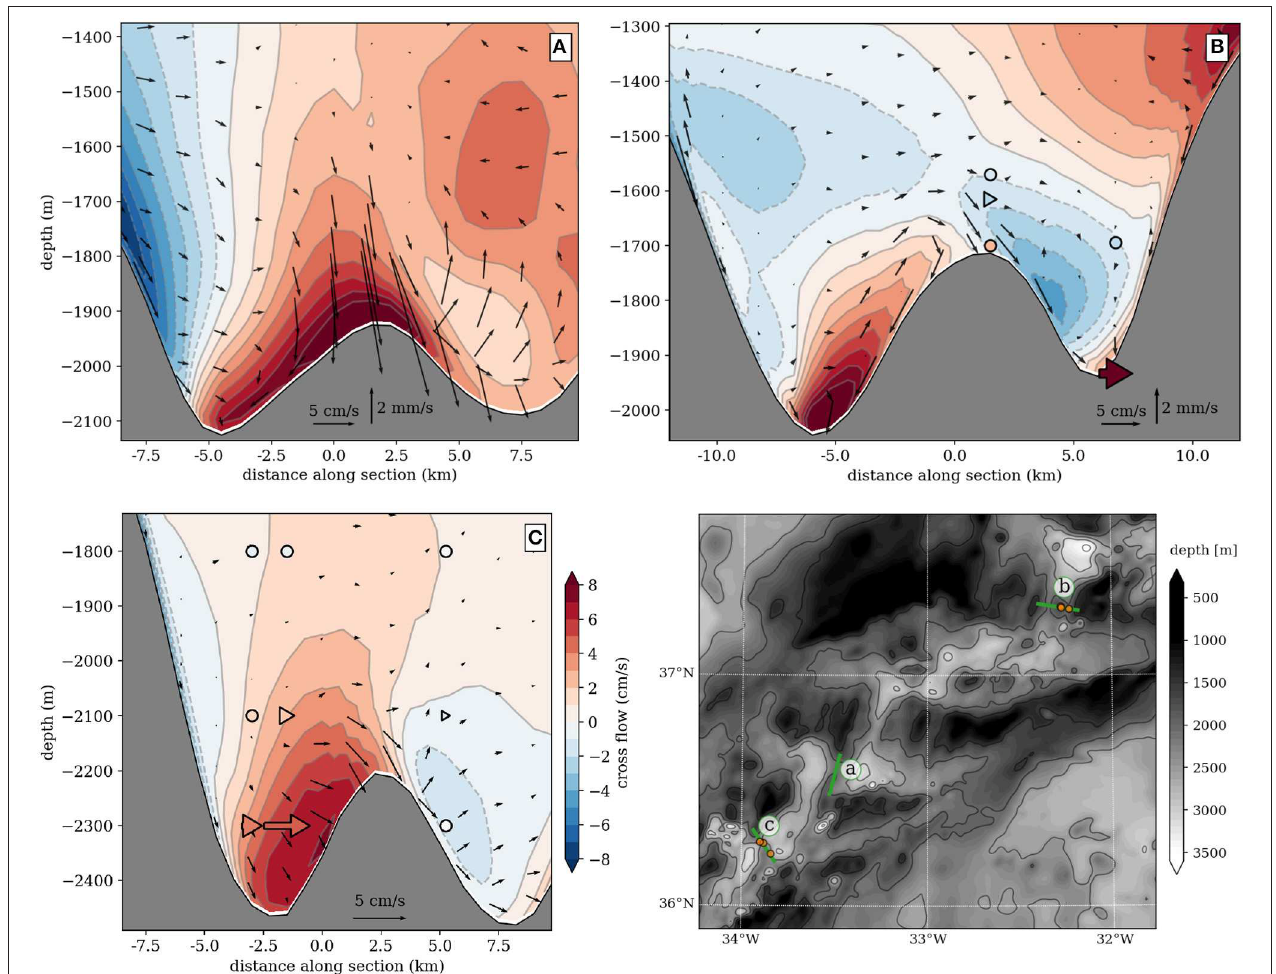
FIGURE 3 | Mean flow at vertical sections across the AMAR-FAMOUS (A) , Lucky-Strike (B) , and Rainbow (C) passages, over the 700 m above the deepest point. Colors indicate the cross-section velocity, for an observer oriented in the same direction as the dominant up-valley flow, and arrows represent the velocity in the section plane. Note that arrows pointing toward (or away from) the topography result from the combination of the cross-section component of the flow and cross-section gradient of the topography (e.g., at Rainbow, the flow is flowing downward along the downstream flank of the sill). Additional velocity data from observations are superimposed in plain arrows for Rainbow and Lucky-Strike, using the same color-scheme for the cross-section component and the same scale for the along-section component (vertical velocity was not measured). A dot is used if the along-section observed velocity is smaller than 0.4 cm/s . The topography is taken from the numerical simulation. The lower right panel shows the location of the sections (green line) over the topography (shallower depth are darker, following the same convention as in Figure 1 ), as well as the locations of the in-situ data (orange circles). All observations are within 700 m of the closest point on the